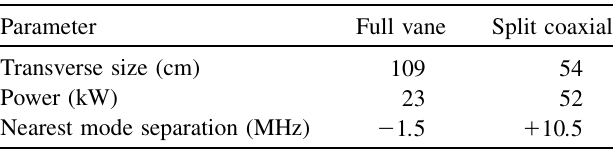
TABLE I. Comparison of important parameters between the full-vane and the window-coupled